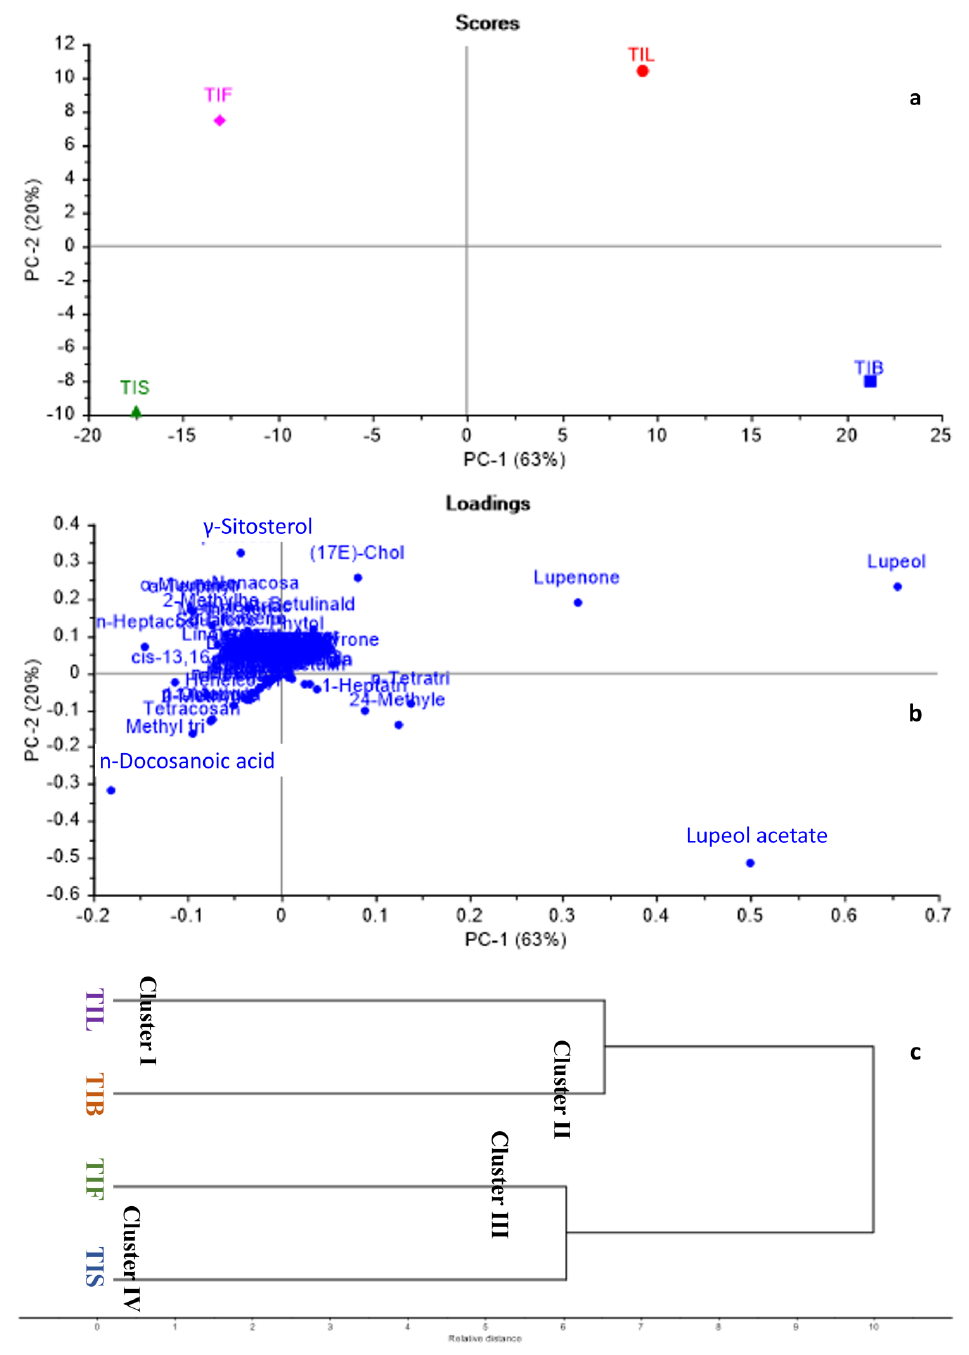
Figure 3. Principal component analysis score plot ( a ), loading plot ( b ), HCA dendrogram ( c ) based on GC-MS metabolites of various T. indica organs as identified in Table